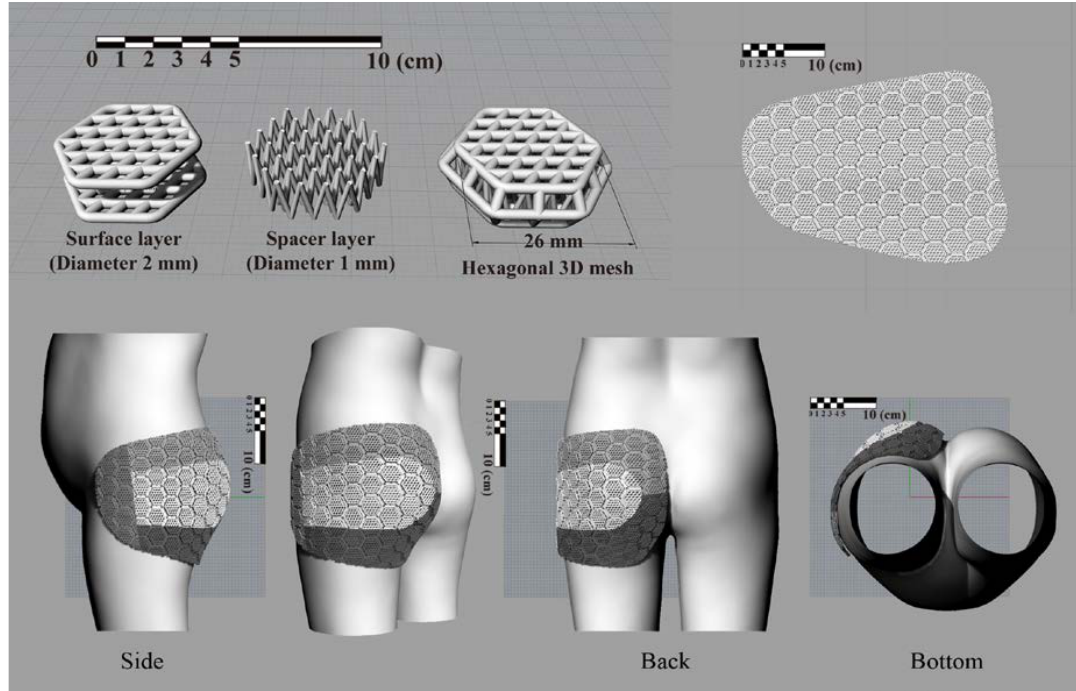
Figure 4. 3D modeling of curved pad.